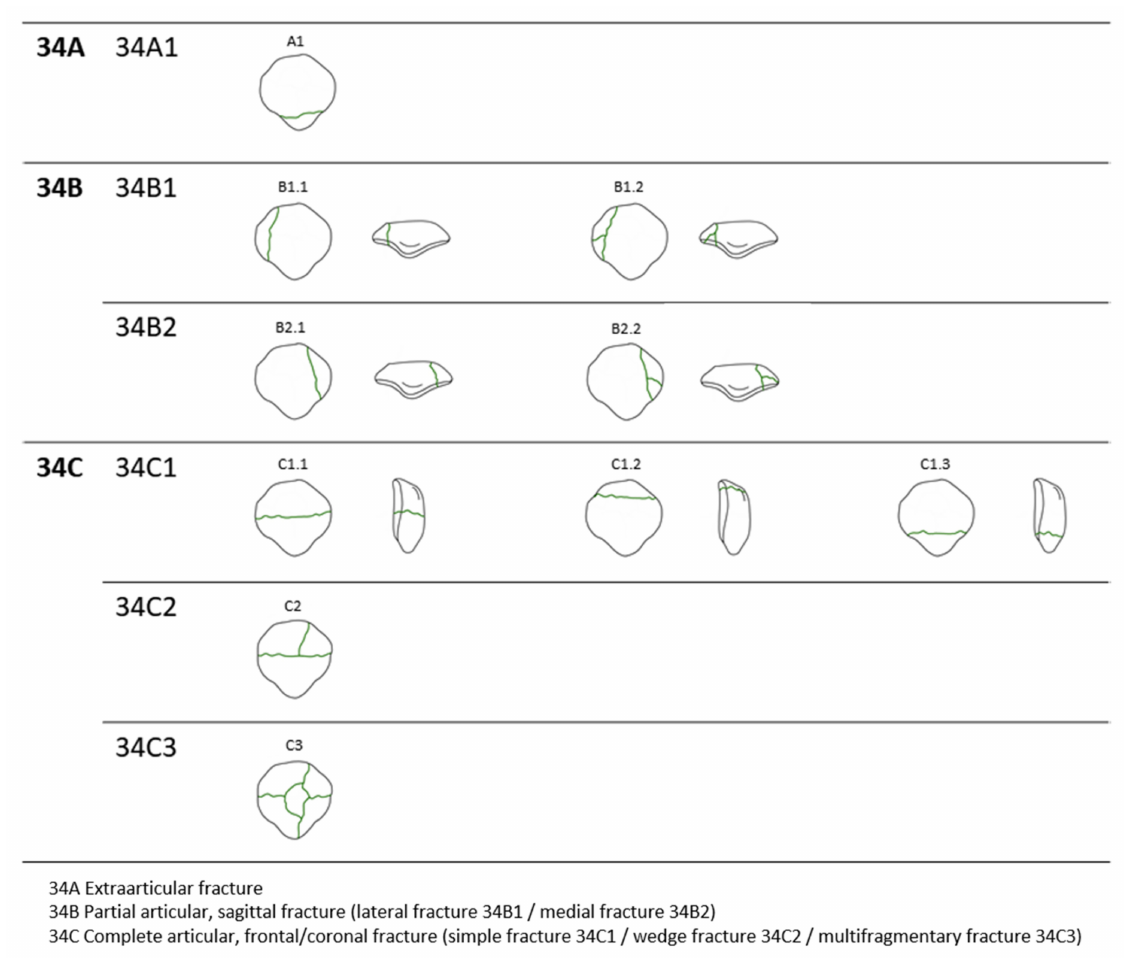
Figure 1. The AO/OTA classification of the patellar